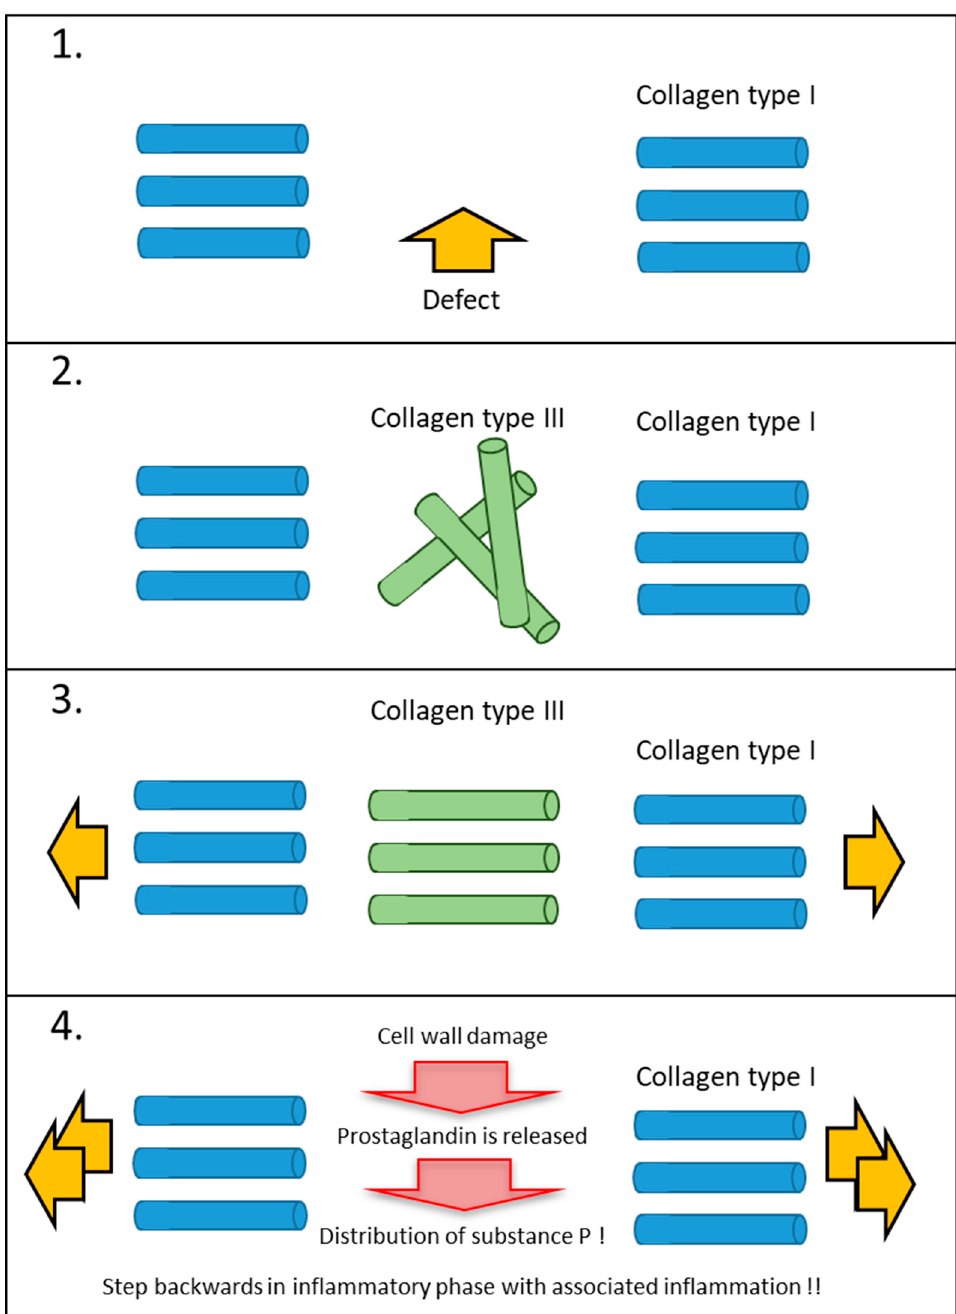
Figure 1. Cellular reactions to differently dosed mechanical stimuli (tissue or scar tissue). (Source: own illustration). (1) A deep dermal injury causes a defective site in the collagen network. The matrix is